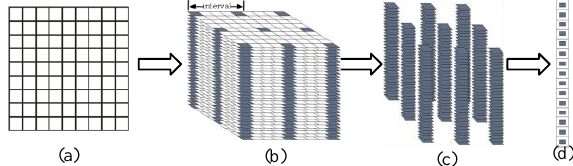
Figure 9. The fast computing scheme for the HOPC